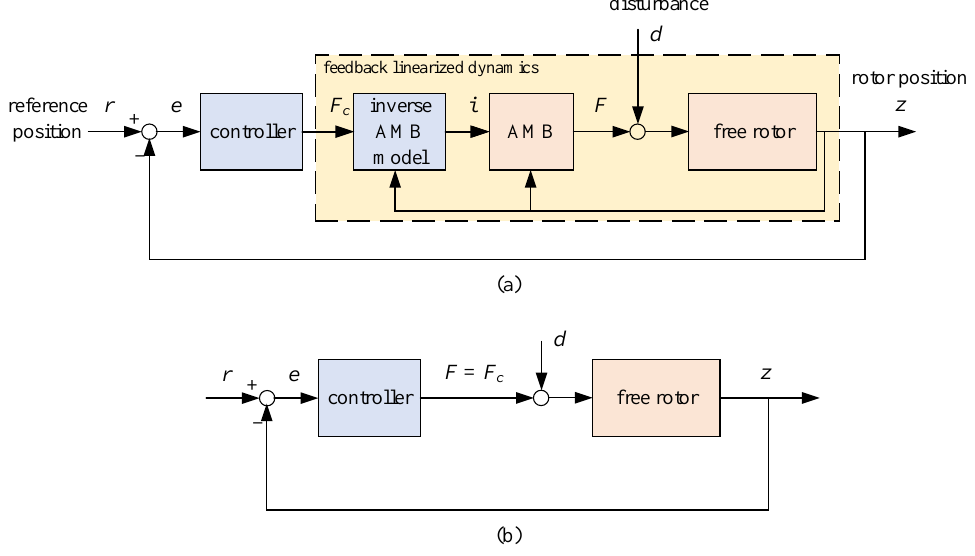
Figure 2. Rotor-AMB control scheme: ( a ) with feedback linearization (inverse AMB model) ( b ) equivalent